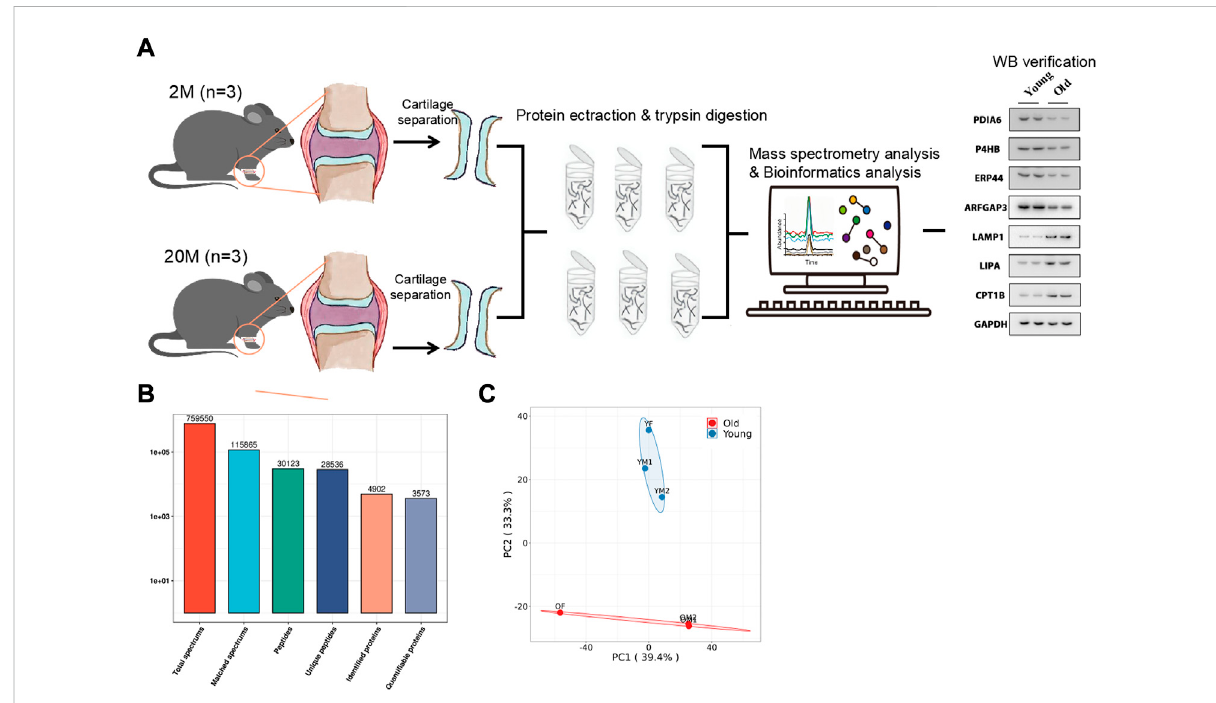
FIGURE 1 Overview of the proteomic analysis results. (A) The work fl ow of this paper. (B) Number of Peptides and proteins Identi fi ed by proteomics. (C) Principal Component Analysis Chart of Mouse articular